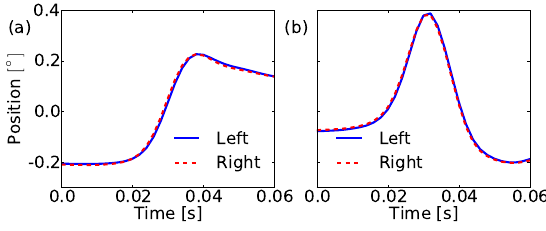
Figure 6 . Graph of the shapes of the first two principal com- ponents which go into our model for a microsaccade. (a) We have for pc 0 a steplike shape which has the tendency to re- turn after it reached the maximum amplitude. This over- shoot, typical for microsaccades, dominates together with the almost linear increasing shoot part this shape. (b) The shape of the second component pc 1 is bumplike. It identifies how much overshoot each microsaccade has. The left (blue solid line) and right (red dashed line) eye agree in the shape of the first two principal